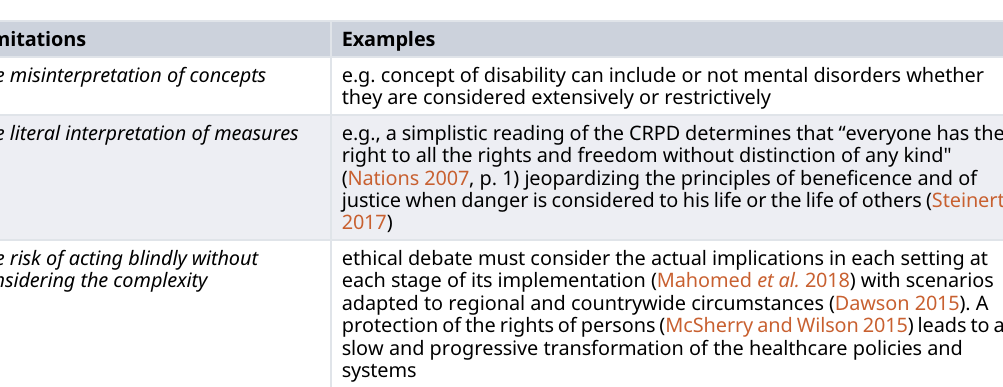
Table 3. The limitations of the